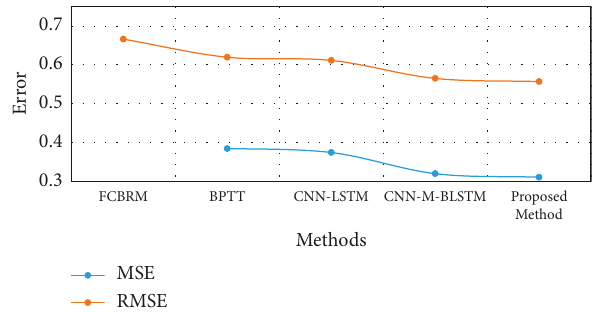
Figure 13: Comparative analysis of the proposed method with state of the arts. The blank area for FCBRM shows that there is no MSE value provided by